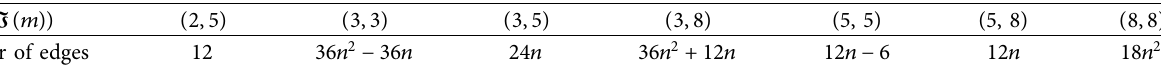
Figure 3: Benzenoid hex planar octahedron structure of dimension 2. Table 3: Edge partition of benzenoid hex planar octahedron